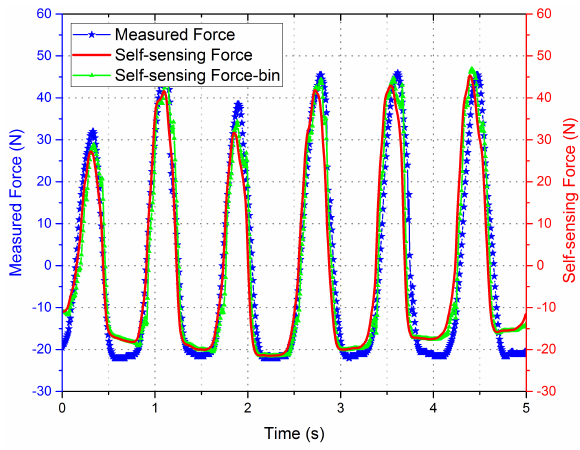
Figure 10. Comparison of the self-sensing and measured force curves with drive current = 0 A.